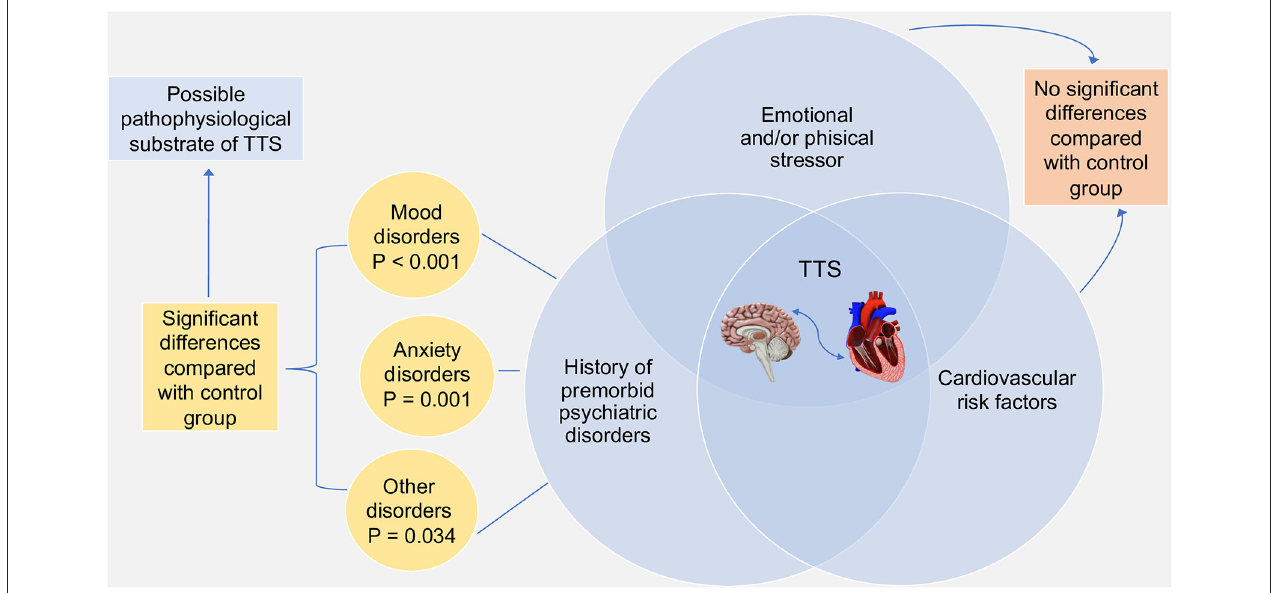
FIGURE 1 | Pathophysiological substrates of TTS and major results of the study.